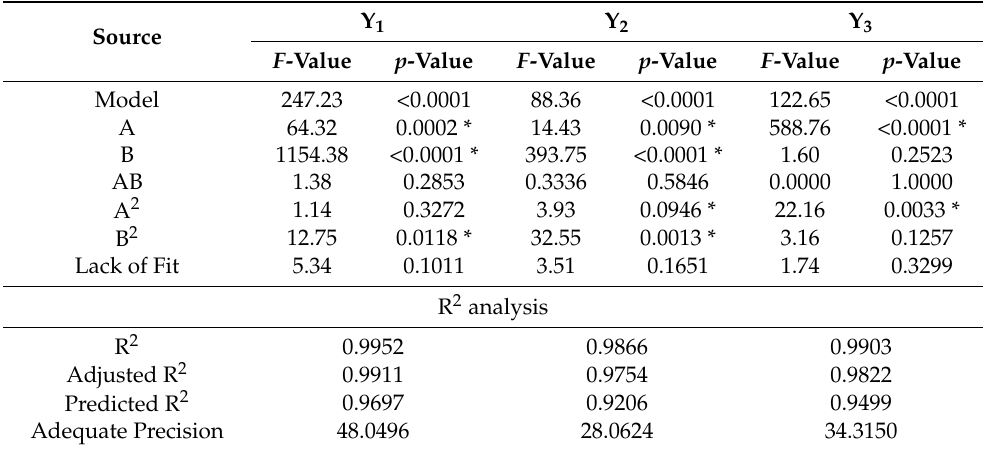
Table 2. Statistical analysis results of responses.